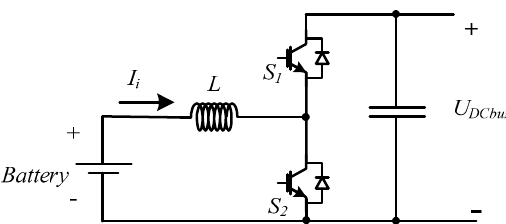
Figure 9. Topology of the Buck-Boost converter.